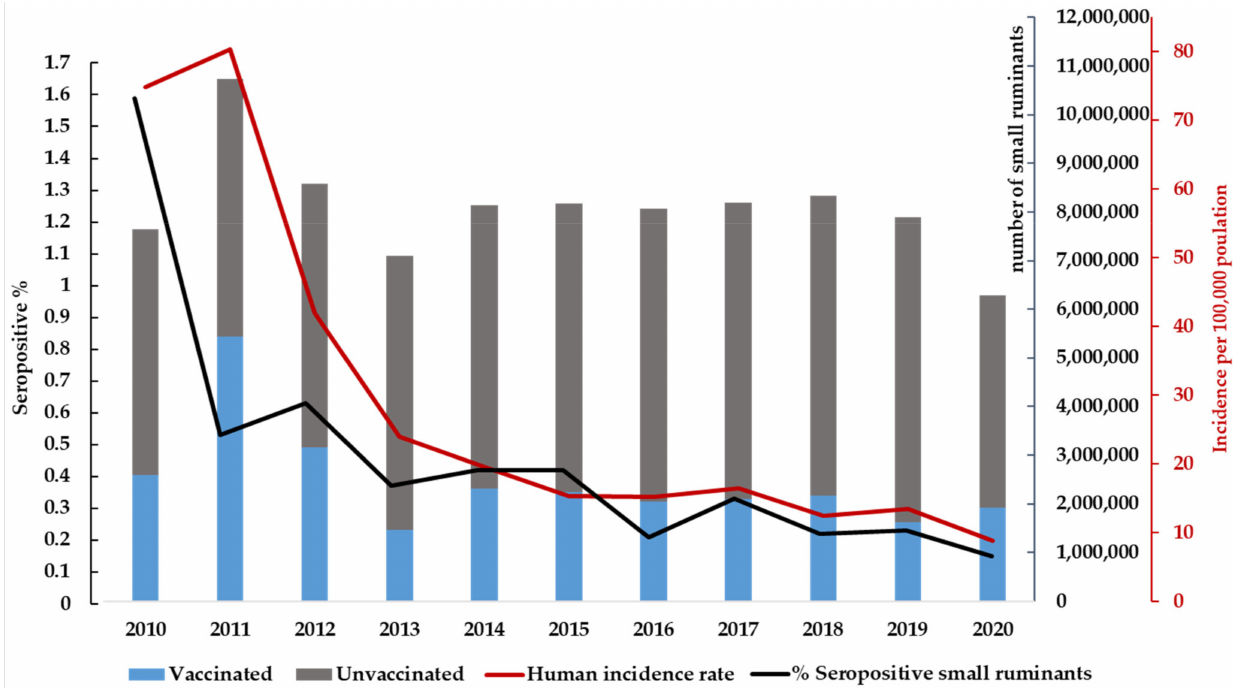
Figure 6. Number of vaccinated small ruminants in Kyrgyzstan from 2010 to 2020, based on data from RCQHDI and